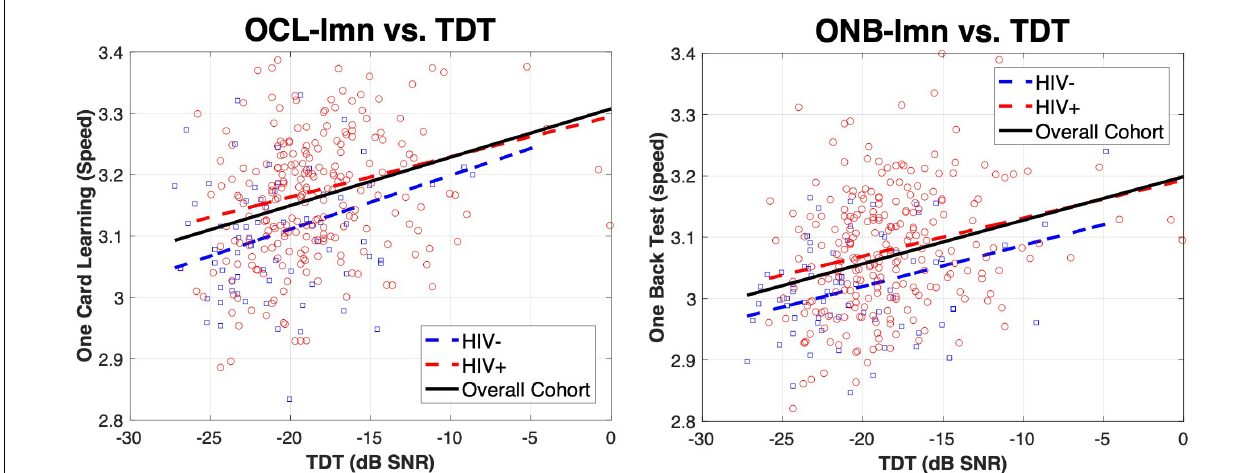
FIGURE 1 | Relationship of OCL-lmn and ONB-lmn with TDT for HIV– and HIV + individuals. Panels show the relationship of OCL-lmn (left) and ONB-lmn (right) for HIV– (blue squares) and HI + (red circles). Lines indicate a least-squares fit for HIV– (blue dotted line), HIV + (red dotted line), and the overall cohort (black solid line). OCL-lmn is the mean of the log 10 transformed reaction times for correct responses during the One Card Learning task. This task was to quickly and accurately recognize if a playing card has been presented before throughout the duration test. Lower scores equate to better performance. ONB-lmn is also the log 10 transformed reaction times for the One Back Test using playing cards. Results show significant positive relationships between TDT and OCL-lmn and